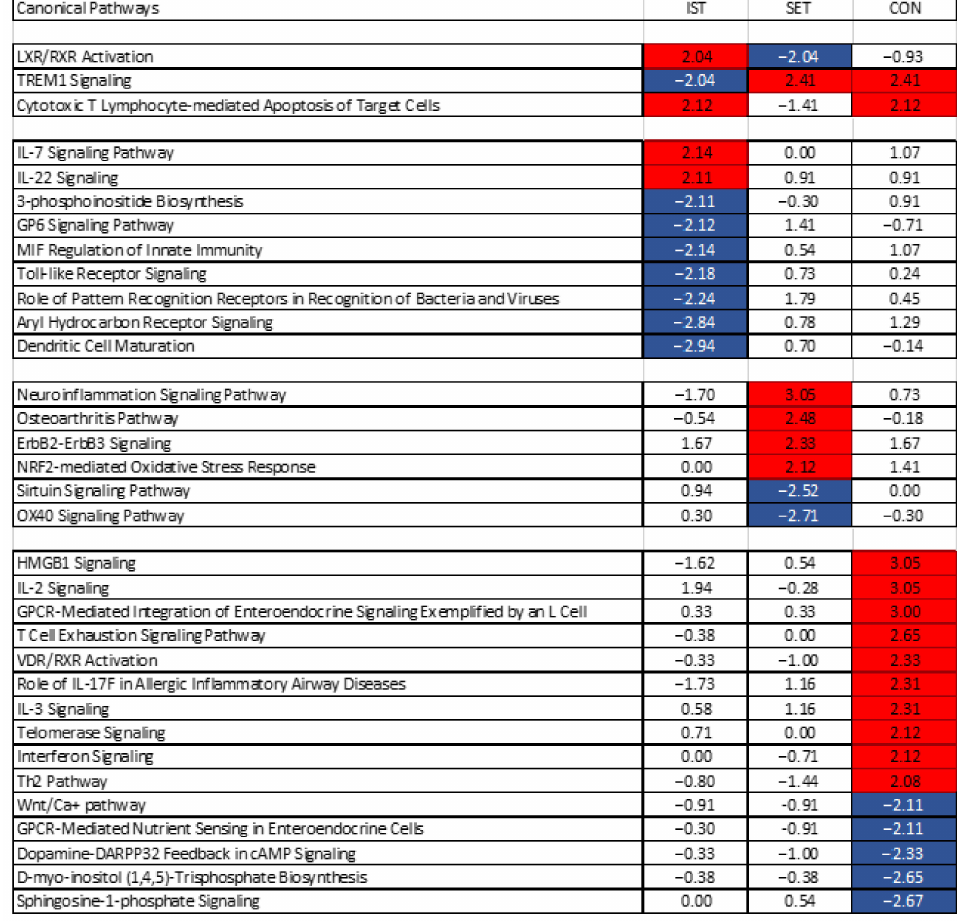
Figure 6. Heatmap of the significantly enriched pathways across the intervention groups. Blue: path- ways that were significantly blunted after the intervention (z-score ≤ − 2). Red: Pathways that were significantly activated after the intervention (Z-score ≥ 2). LXR/RXR = Liver X Receptor/Retinoid X Receptor, TREM = Triggering Receptor Expressed On Myeloid Cells, IL = Interleukin, GP = Glycopro- tein, MIF = Macrophage migration Inhibitory Factor, OX40 = CD134, HMG B = High Mobility Group Box, GPCR = G-protein coupled receptor, VDR = Vitamin D receptor, Wnt = Winless/integrated, DARPP = dopamine- and cAMP-regulated neuronal phosphoprotein. The pathway “cytotoxic T lymphocyte-mediated apoptosis of target cells” was